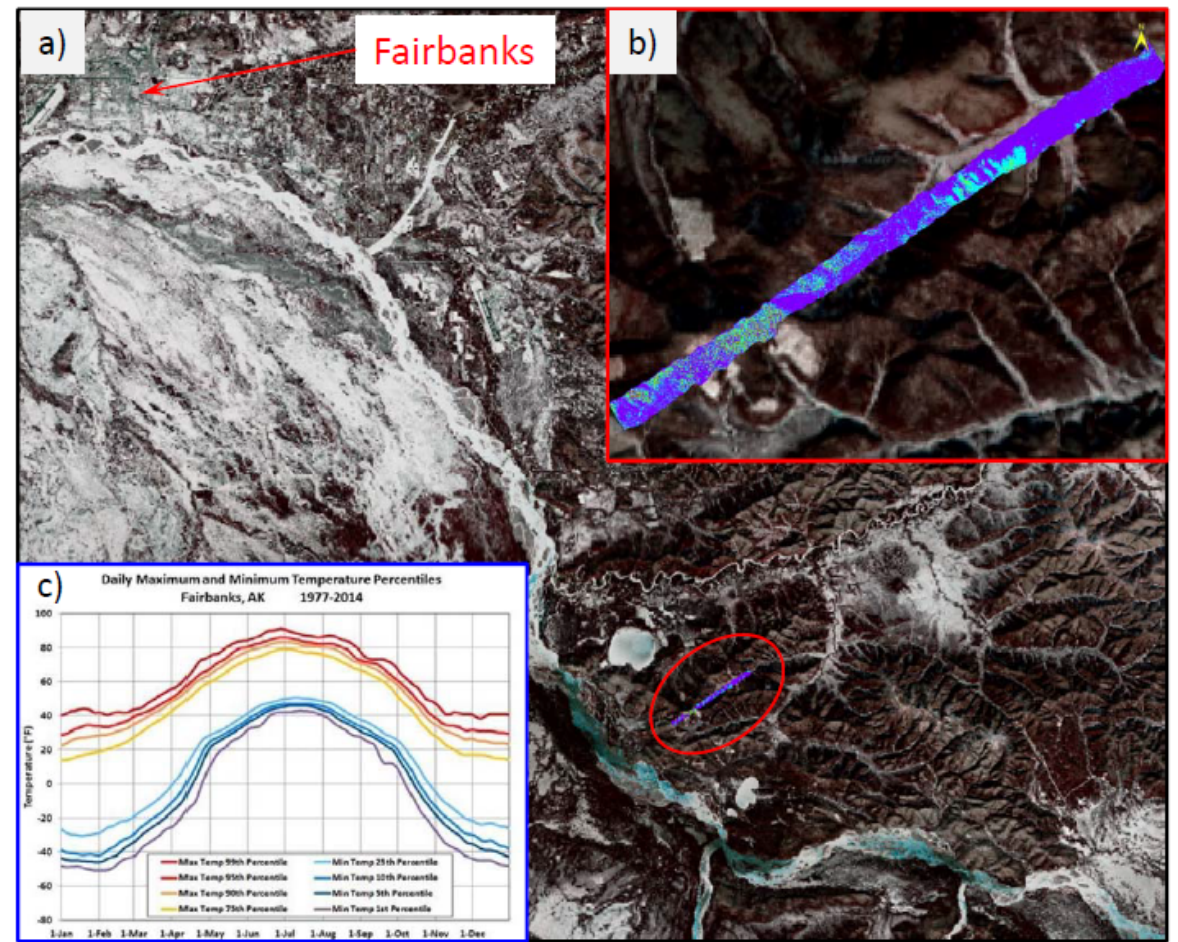
Figure 1. ( a ) Landsat 8 scene of 26 March 2014, showing the areas surrounding the study site (red oval). Snow-covered peaks, rivers, valleys, and lakes are visible as bright white colors. ( b ) LiDAR-derived canopy heights are in the inset as a color image (taller trees are green and cyan while shorter trees are blue). ( c ) Daily maximum and minimum temperature percentiles are also shown (source: https://www.explorefairbanks.com/, accessed on 10 December 2020).